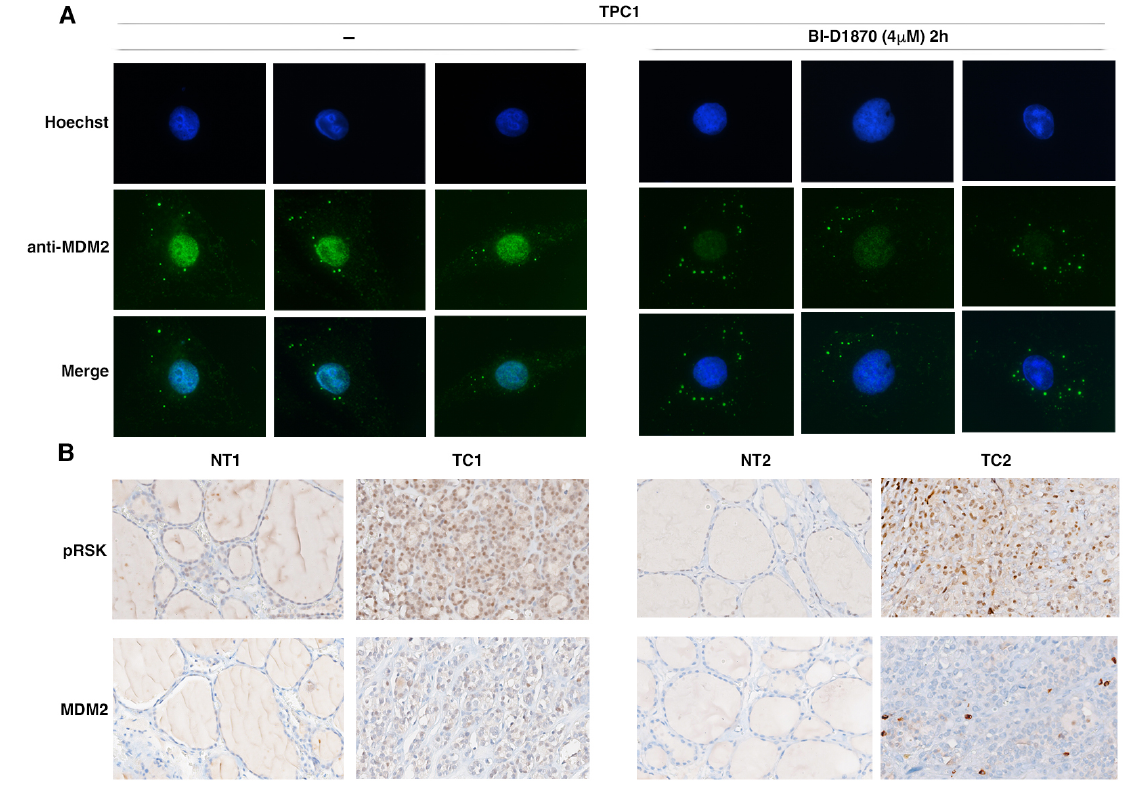
Figure 7. p90RSK activation is associated with MDM2 stabilization in TPC1 cells and in primary thyroid tumors. ( A ) Staining of MDM2 by immunofluorescence assay in TPC1 cells treated or untreated with 10 µM BI-D1870 for 2 h. Untreated TPC1 cells show strong nuclear staining for MDM2; BI-D1870-treated TPC1 cells show reduced and predominantly cytosolic staining for MDM2. Hoechst staining was used to visualize cell nuclei. The experiment was performed in triplicate, and at least 90 representative cells were observed. Representative fields of treated and untreated cells are